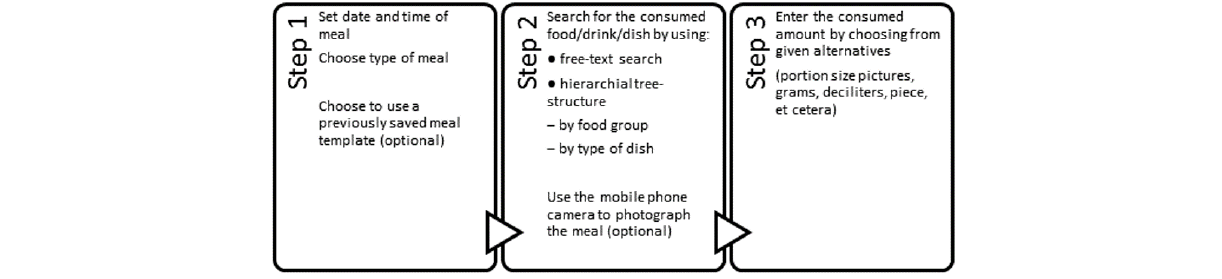
Figure 1. The steps involved in registering dietary intake in a newly developed Swedish mobile phone app. The three steps are repeated until all foods and drinks in a meal have been entered, and the meal is thereafter saved and automatically sent to a server for storage and calculation of energy and nutrient